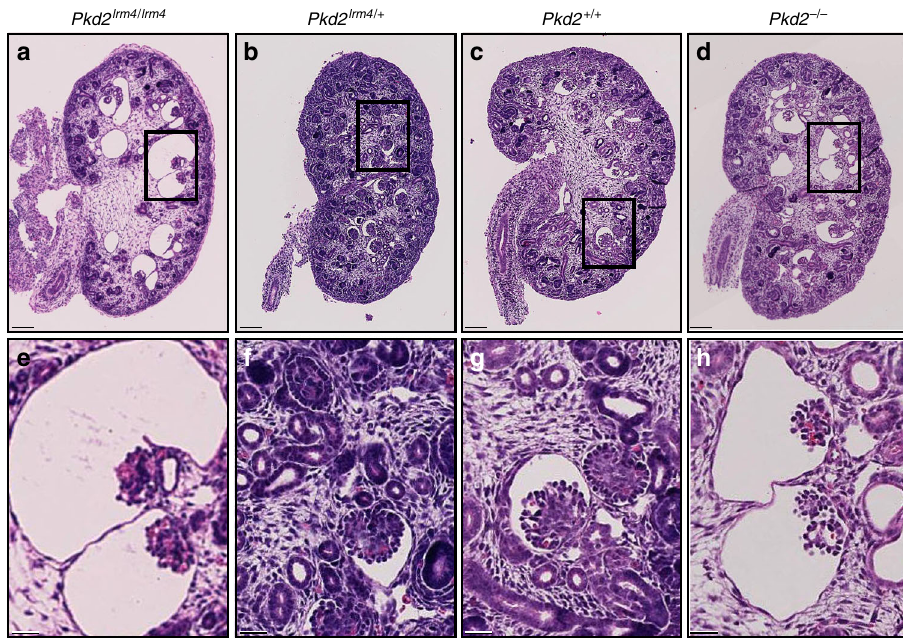
Fig. 1 Pkd2 lrm4 causes kidney cysts. Cysts develop in Pkd2 lrm4/lrm4 kidneys ( a ) at E15.5 but not in Pkd2 lrm4/ + ( b ) or in Pkd2 + / + ( c ). Cysts are comparable to those seen in Pkd2 − / − kidneys at the same age ( d ). Scale bar: 100 µ m. Boxed areas in a – d are represented in e – h . Glomerular cysts are visible in both Pkd2 lrm4/lrm4 ( e ) and Pkd2 − / − ( f ). n = 5 E15.5 kidneys from 5 independent litters were examined for each genotype. See Supplementary Fig. 2 for representative images of embryonic kidneys. Scale bar 25 µ